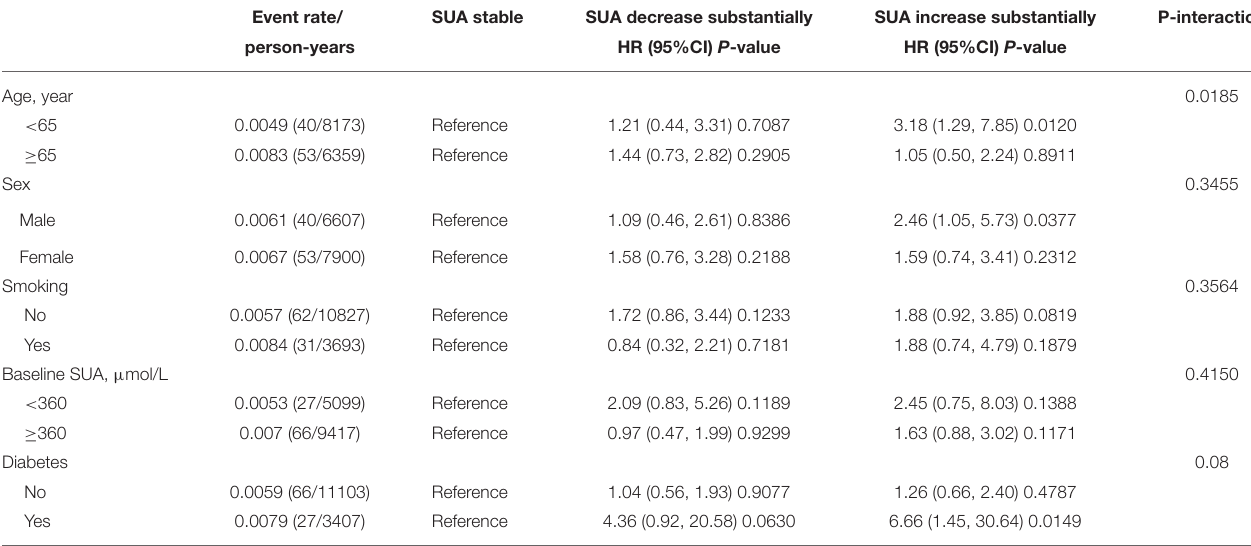
TABLE 3 | Subgroup analysis of SUA change with ischemic